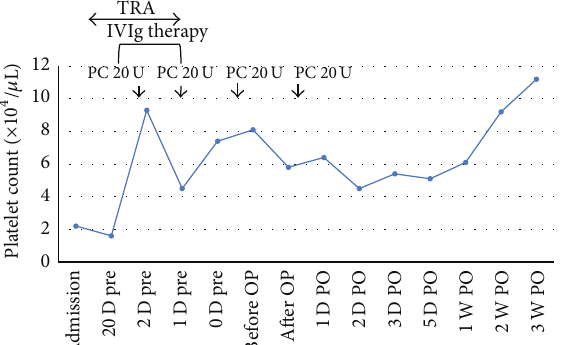
Figure 2: The platelet count is controlled and increased to 81000/ 𝜇 L just before the operation. An additional 20 units of platelets are transfused after the operation. TRA: thrombopoietin receptor ago- nist; PC: platelet concentrate; IVIg: intravenous immunoglobulin; U: unit; Pre: preoperation; OP: operation; PO: